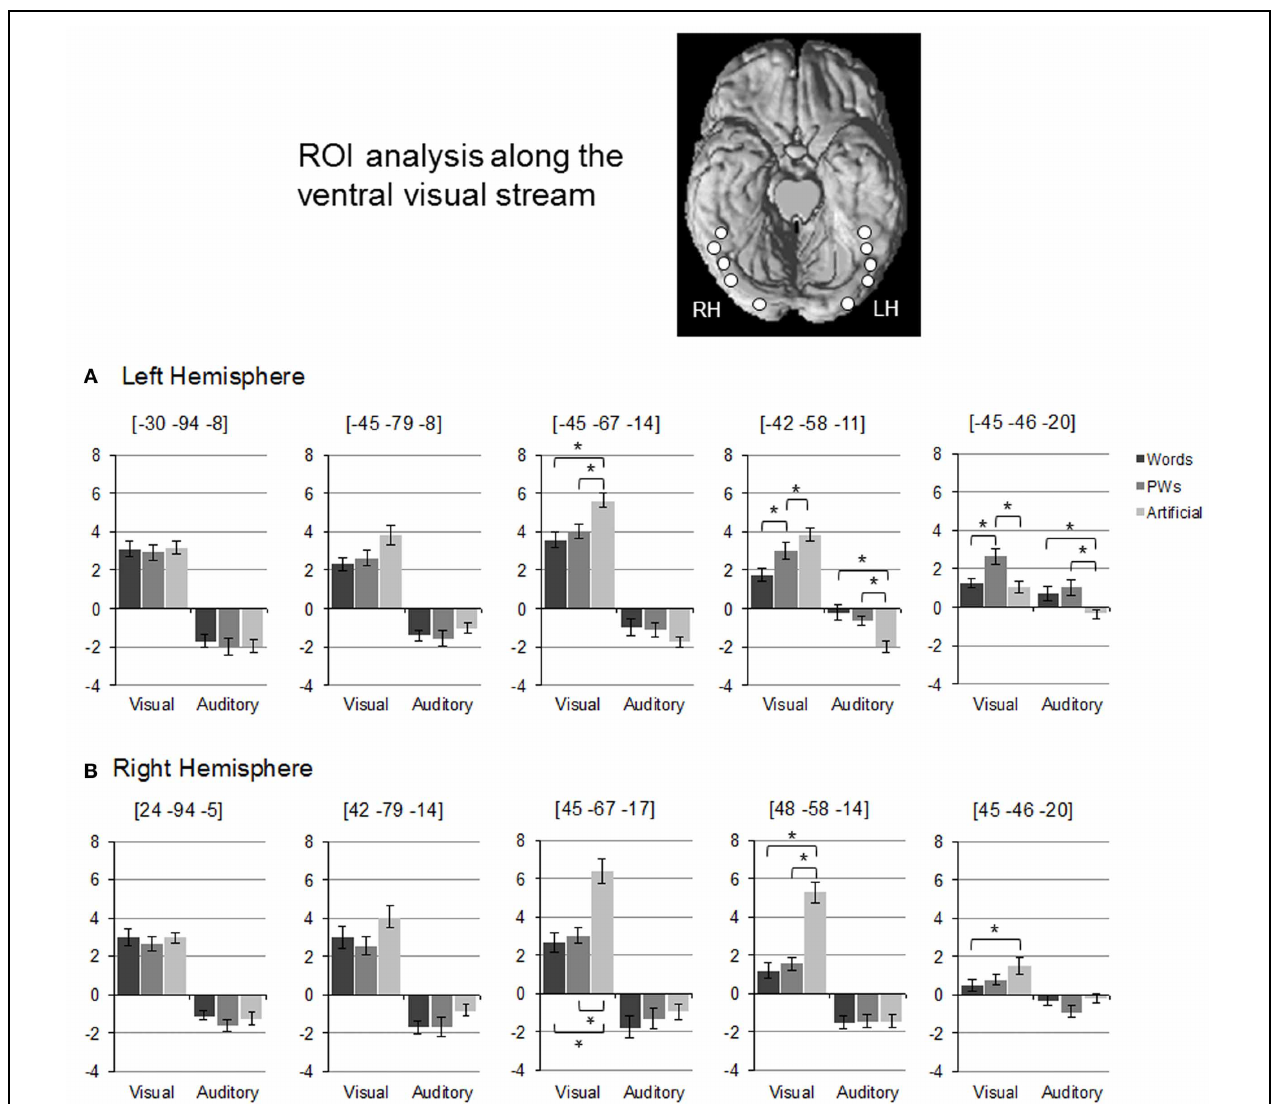
FIGURE 2 | Region of Interest Analysis: (A) and (B) depict mean brain activity estimates (given in arbitrary units) for left and right hemispheric ROIs along the ventral visual stream. Error bars denote ± 1 standard error